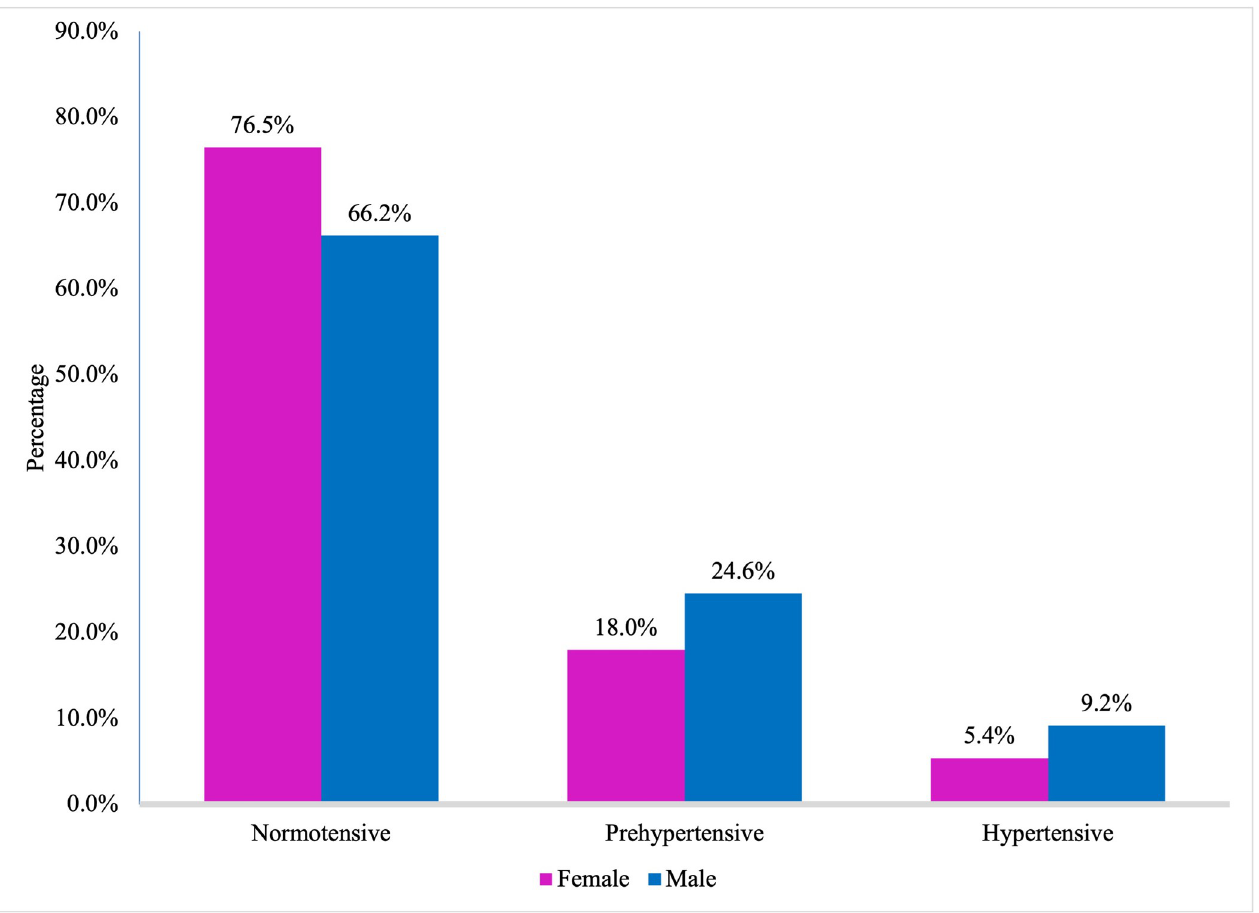
Fig 2. Prevalence of prehypertension and hypertension stratified by sex (n =